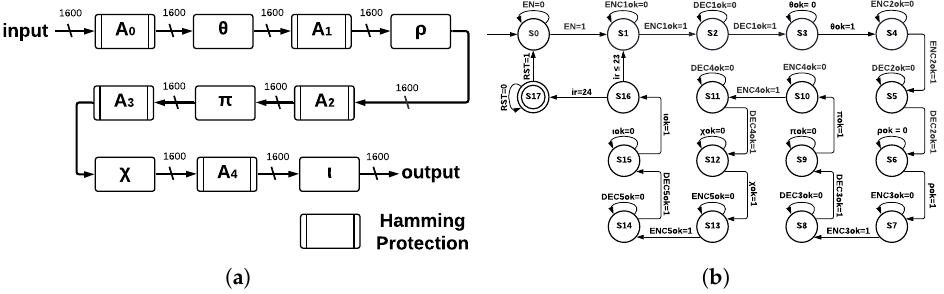
Figure 8. ArchHC at Round level and ArchHC state machine at KECCAK-p level. ( a ) ArchHC at Round level. ( b ) ArchHC state machine at KECCAK-p